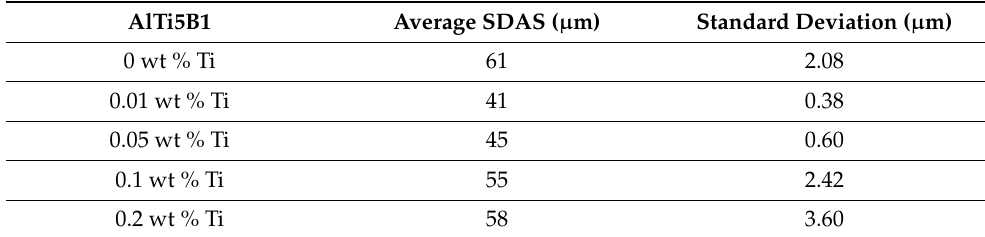
Table 2. SDAS analysis of individual samples in AlSi7Mg0.3